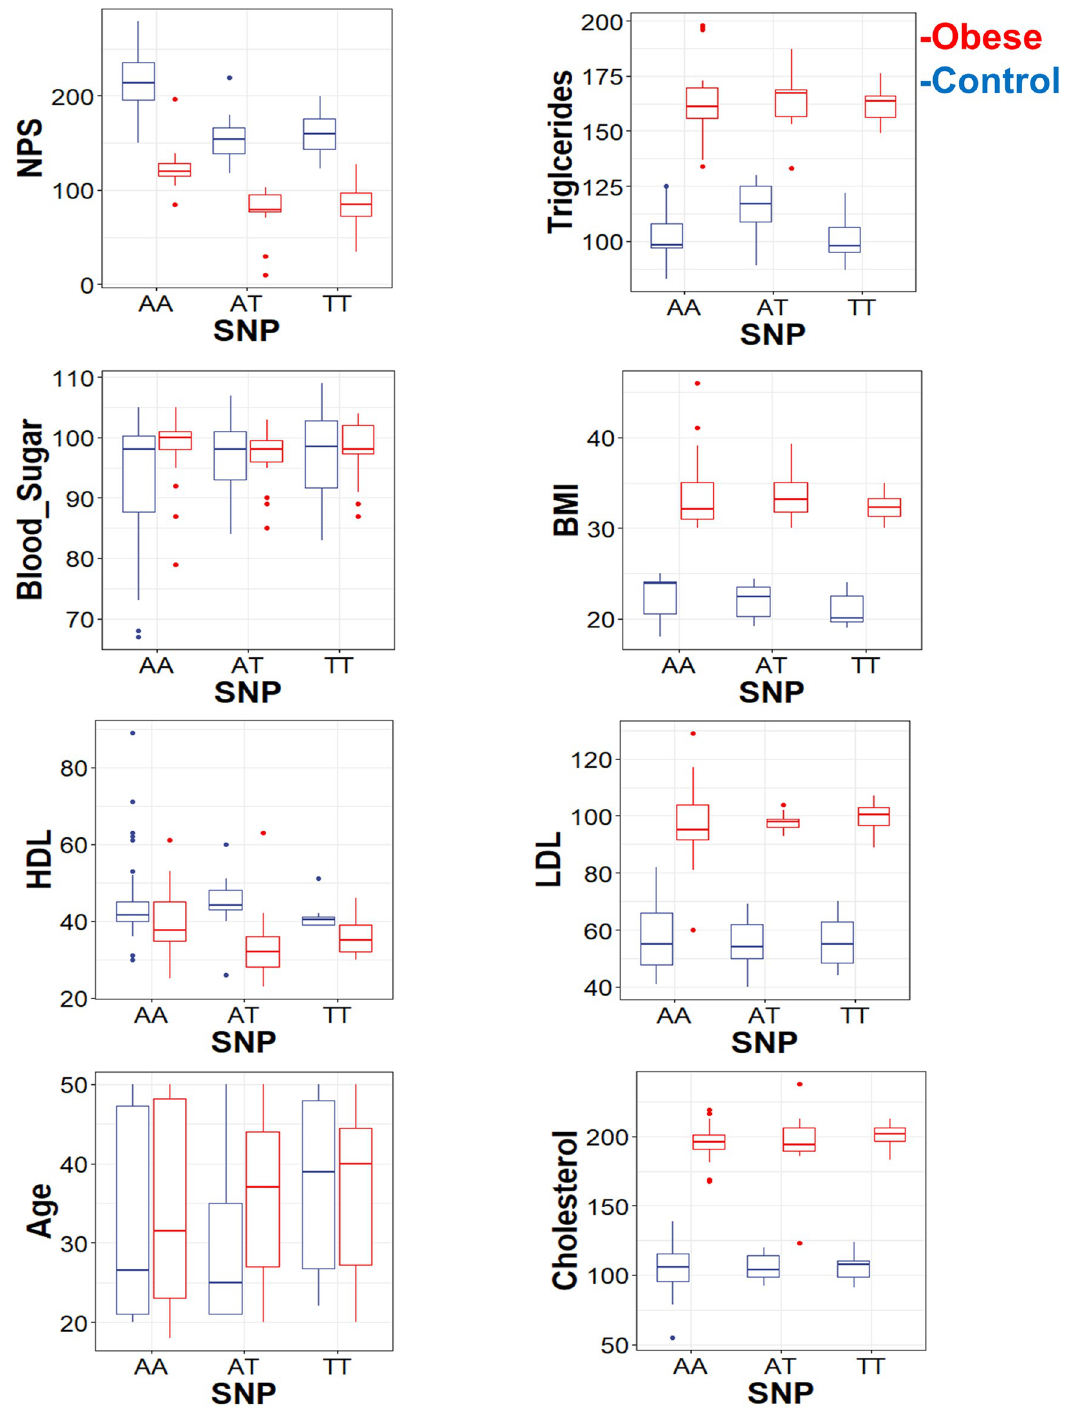
Fig 2. Two-way ANOVA analysis with obesity and genotype as the independent variables and NPS, triglycerides, blood sugar, BMI, HDL, LDL, age, and cholesterol are significantly p = 0.0001 different for different genotypes and for obese vs non-obese subject.